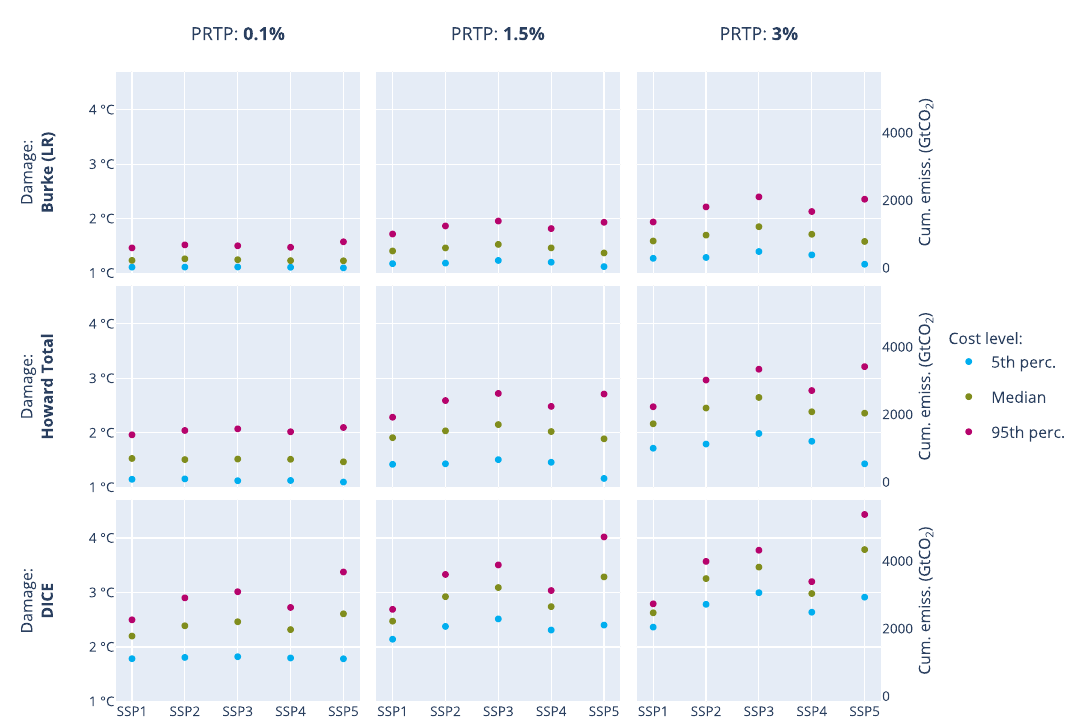
Fig. 5 Optimal temperature in 2100 (cost-bene fi t setting). The optimal end-of-century temperature is shown for three different pure rate of time preference rates (columns), three damage functions (rows) and mitigation cost levels (colours). The median value of the TCRE is used for each scenario here. Therefore, the end-of-century temperature corresponds linearly to the cumulative CO 2 emissions from 2020 to